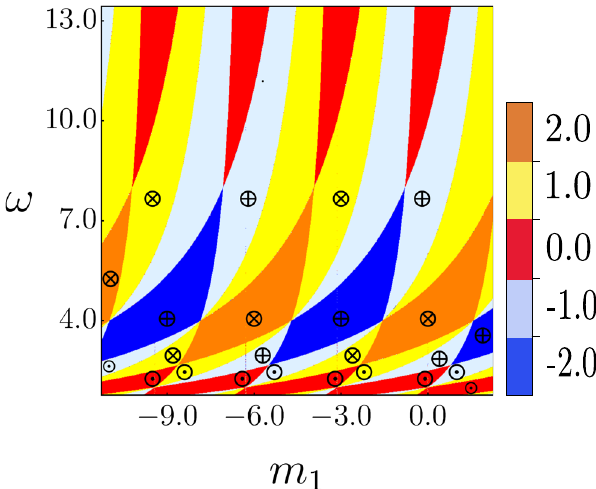
Fig. 2 Global phase diagram of a periodically driven time-reversal symmetry breaking insulator. Here, we set t 1 = t 0 = 1 and m 0 = 3 [Eq. (1)], such that the static system is a trivial insulator, and m 1 and ω are, respectively, the amplitude and frequency of the external periodic drive [Eq. (3)]. In the high-frequency regime ( ω ≳ 8), the system only supports Floquet topological insulators (FTIs) with the Chern number C = ±1 and trivial ones with C = 0 [Eq. (2)]. By contrast, in the intermediate and low- frequency regimes ( ω ≲ 8), the system in addition accommodates FTIs with C = ±2 and the π -trivial insulator with C = 0. FTIs supporting normal (anomalous) dislocation modes at quasienergy μ = 0 ( ± ω /2) at the Flqouet zone center (zone boundary) are marked by ⊗ ( ⊕ ). Whereas, Floquet insulators simultaneously supporting both normal and anomalous dislocation modes, such as the π -trivial insulator, are identi fi ed by ⊙ . Here, we quote the Chern number of the conduction band, while that for the valence band is exactly the